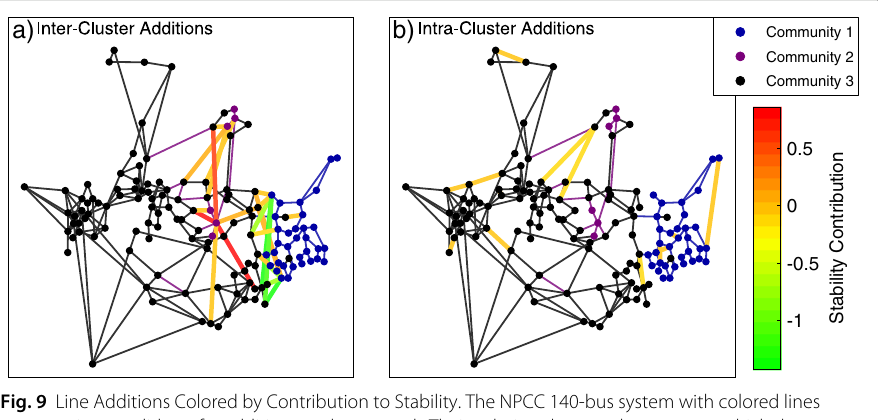
Fig. 9 Line Additions Colored by Contribution to Stability. The NPCC 140-bus system with colored lines representing candidates for additions to the network. Their coloring denotes the extent to which they improved network stability relative to the original network. Green lines afforded the greatest improvement, while red lines left performance largely unchanged. The subnetworks obtained by community detection are colored in black, blue, and purple for reference. Line additions have been separated into a ) connections between distinct communities, and b ) connections within a single